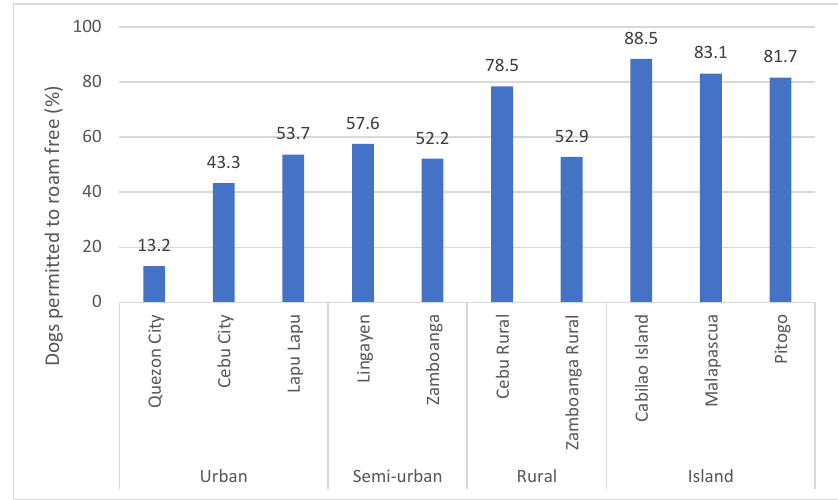
Figure 7. Percentage of dogs permitted to roam free in each survey location.